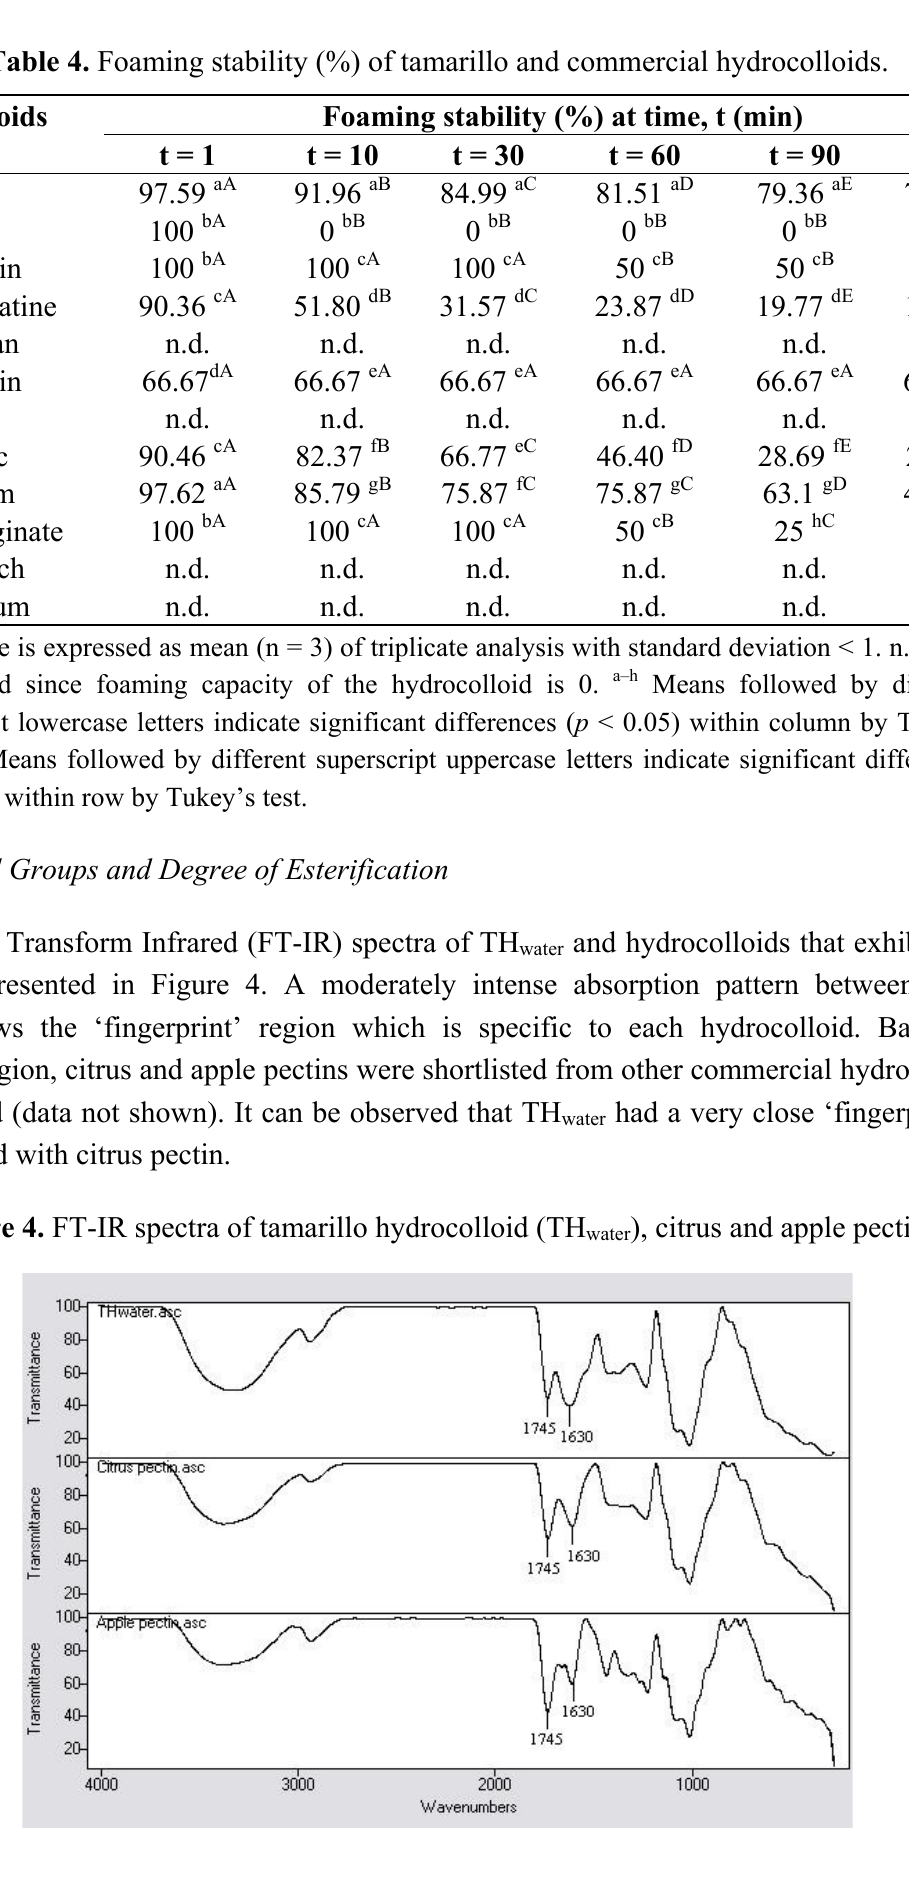
Table 4. Foaming stability (%) of tamarillo and commercial hydrocolloids. Hydrocolloids